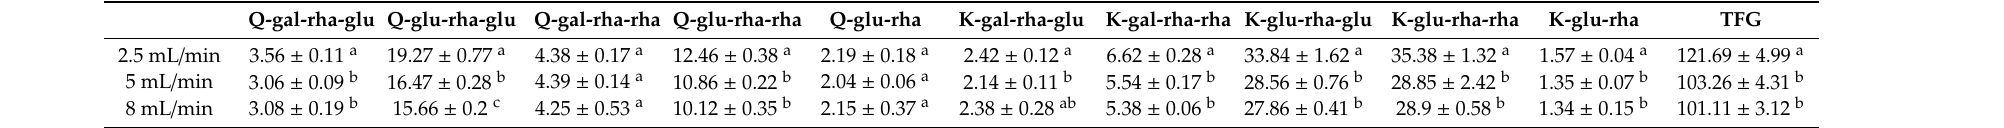
TFG: total flavonol glycosides. Data with di ff erent alphabetic letters in a same column were significantly di ff erent at p =